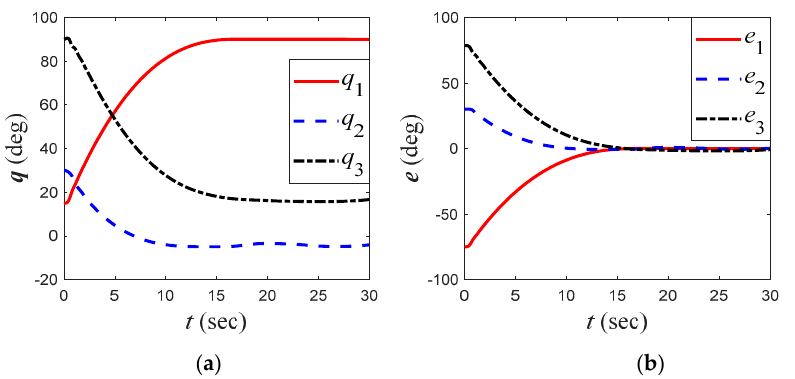
Figure 6. ( a ) Joint angles; ( b ) Joint angle tracking errors.